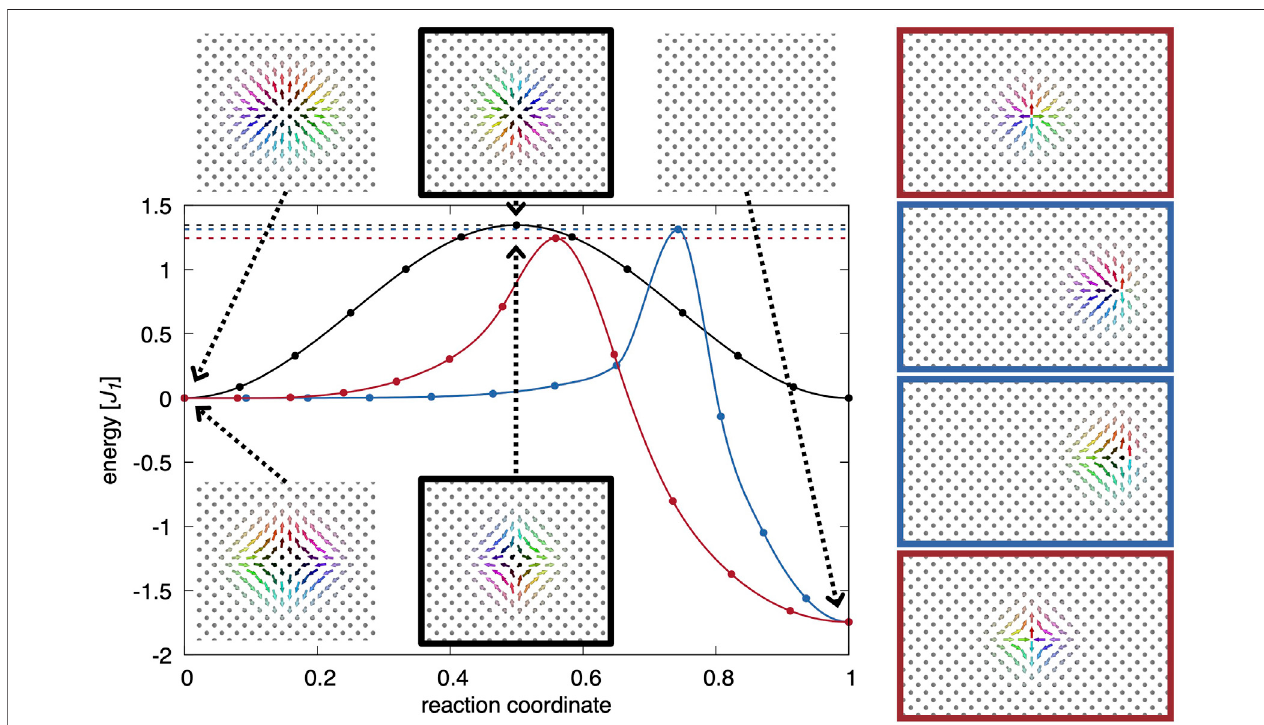
FIGURE2| GNEBpathsandenergybarriers(indicatedbydashedlines)giveninunitsoftheexchangeparameter J 1 fortherotationofan(anti-)skyrmion(black),the collapse of an (anti-)skyrmion (red) and the movement out of the system across the repulsive energy barrier at the boundary of our simulation box created by pinning the boundary spins ferromagnetically (blue). The insets show the relevant states. On the right, transition states are shown for the movement and the collapse. The colored boundary indicates the associated GNEB path degenerated for skyrmion and antiskyrmion. The reference energy refers to a single particle immersed in the ferromagnetic